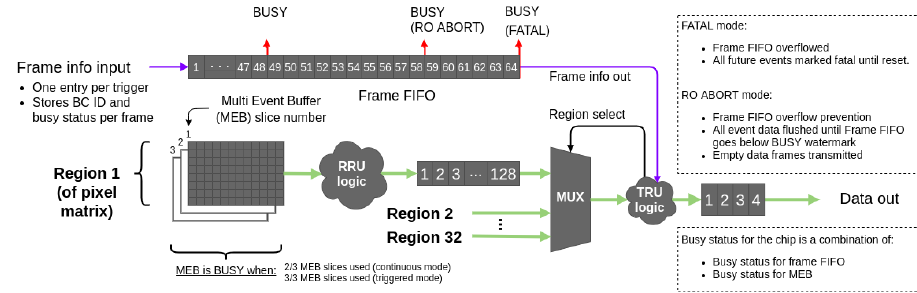
Figure 1: Readout logic in the ALPIDE